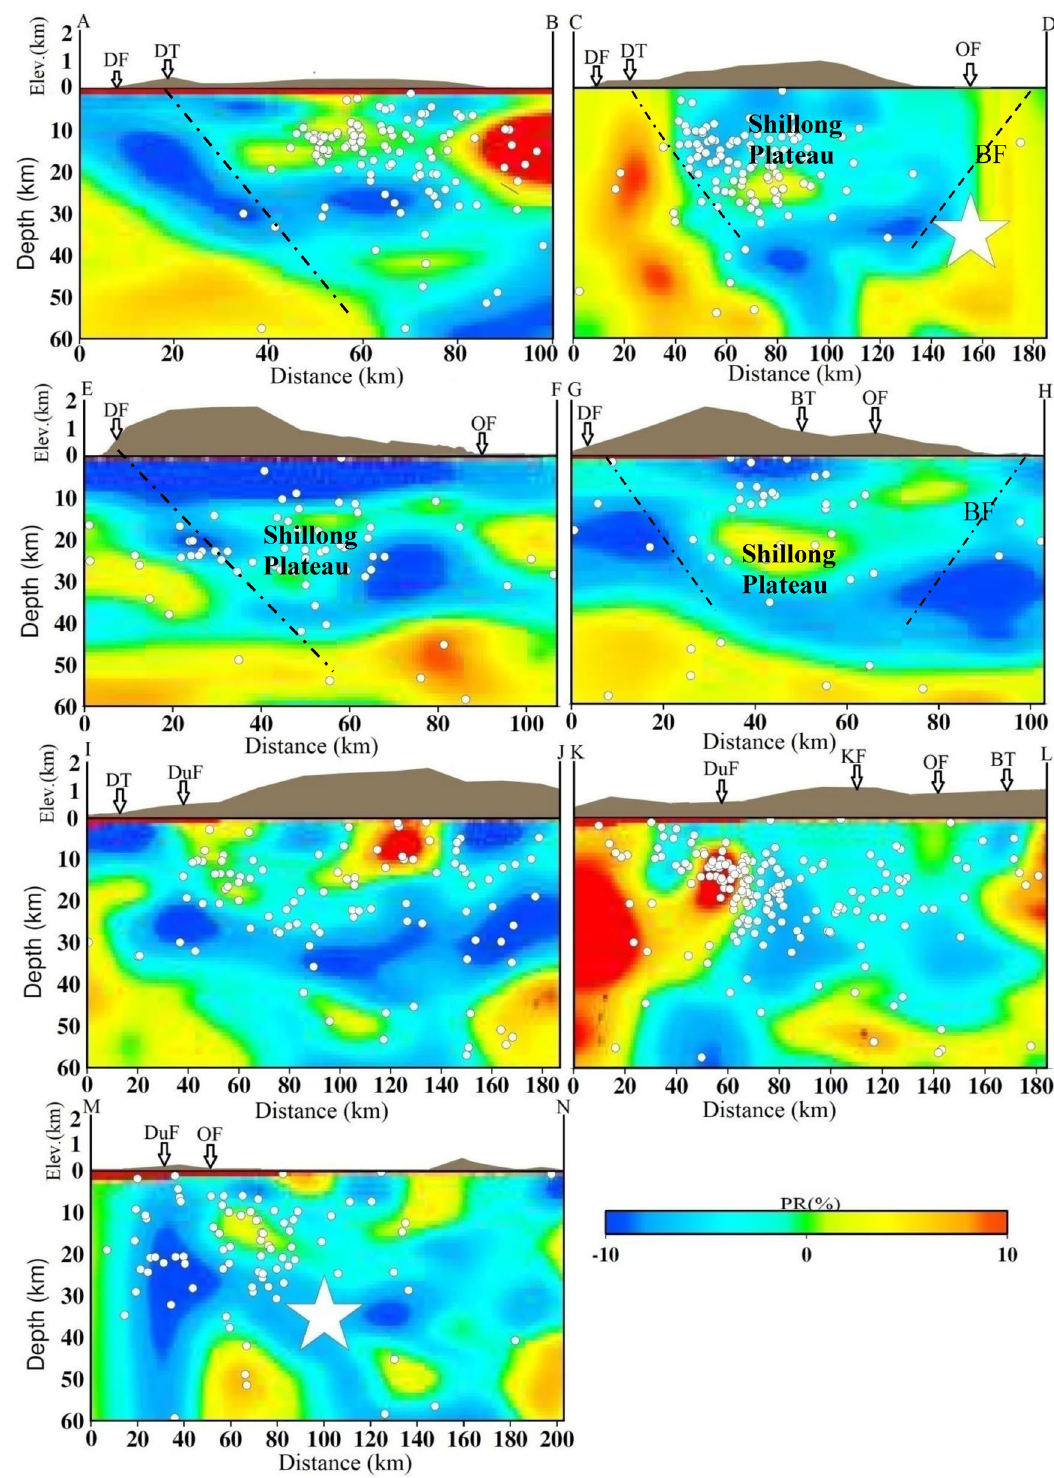
Figure 4. Vertical cross sections of the σ models. The positions of cross sections are shown in Fig. 1. The star shows the 1897 Shillong earthquake (M s 8.7). The geological faults are also